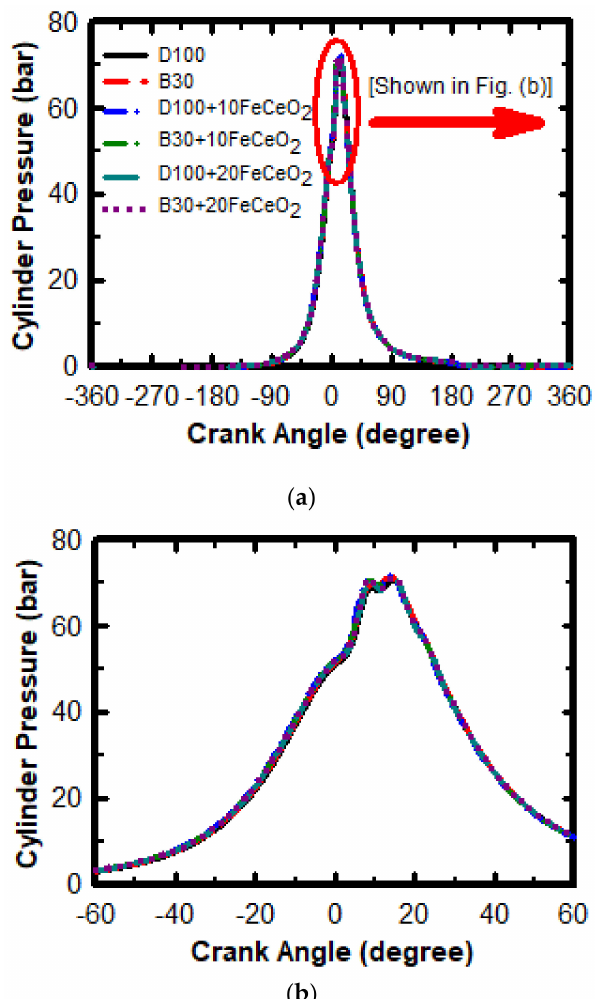
Figure 4. The average pressure ( P ) versus crank angle ( θ ) for 50 successive cycles at engine speed of 2000 rpm and load of 12 N.m for different fuels: ( a ) the data during entire engine cycle and ( b ) the data during combustion.